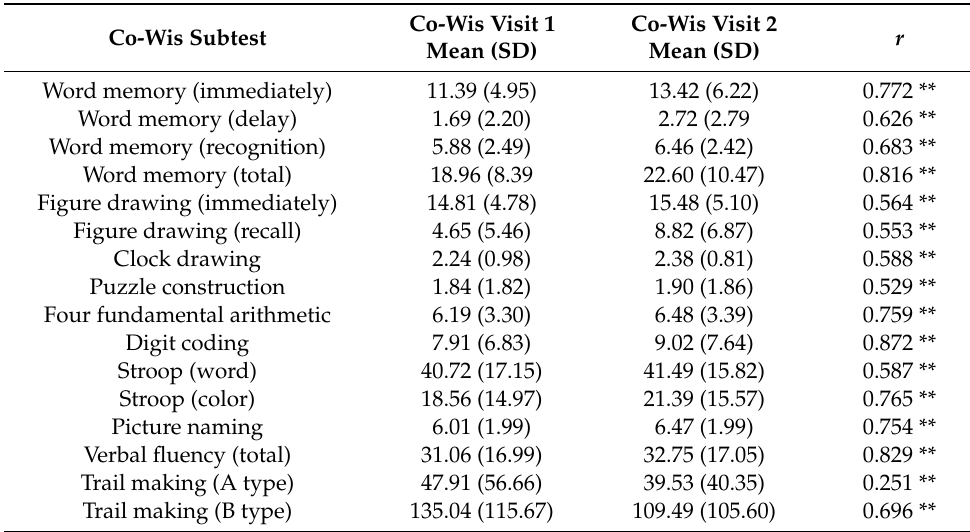
Table 4. Test–Retest reliability of